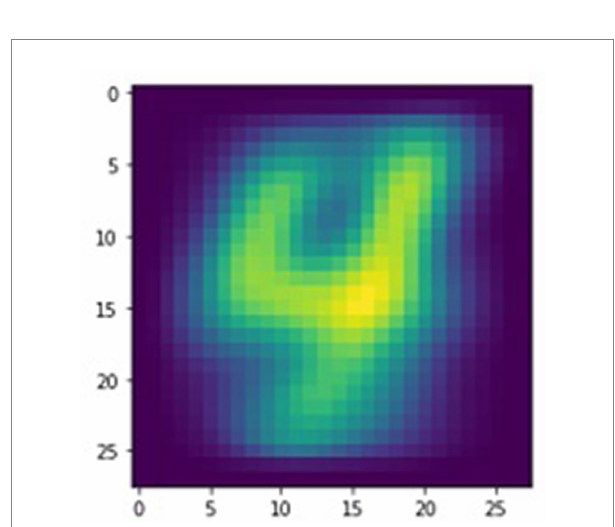
FIGURE 6 Visualization of physical neural network trained on a handwritten numerical